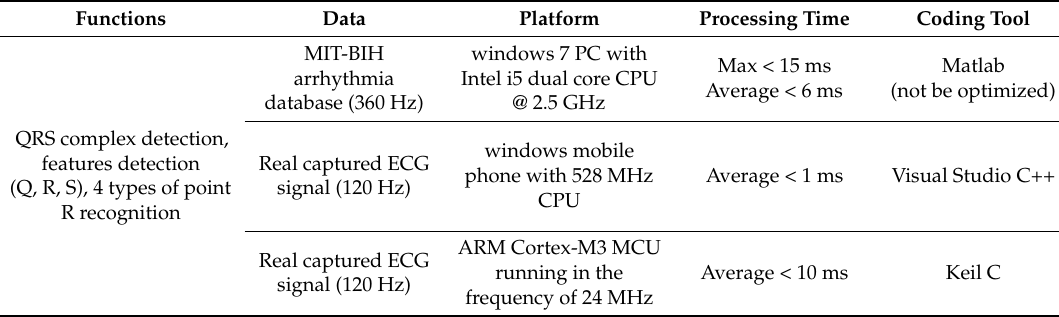
Table 5. Implanted platforms with the corresponding processing times demonstrated in this